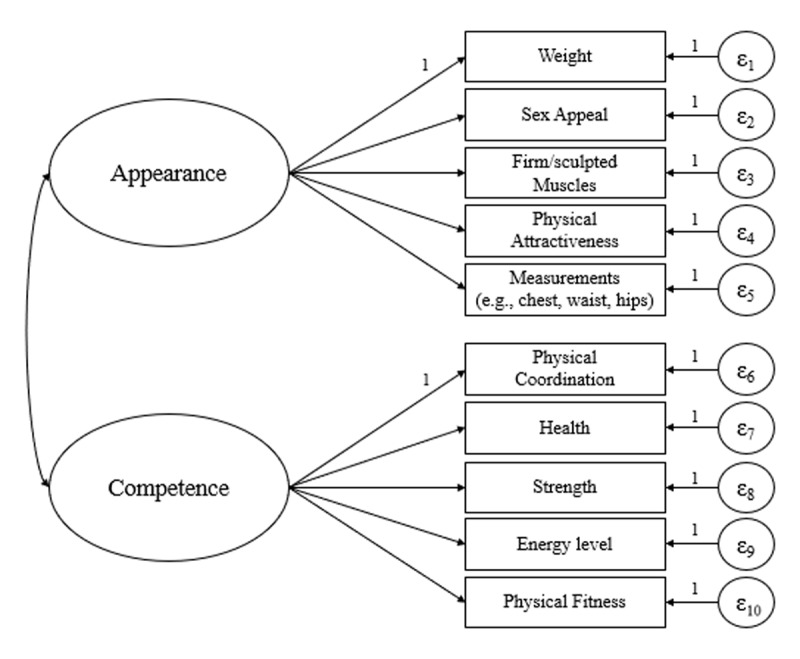
Structural Equation Modeling: Confirmatory Factor Analysis.